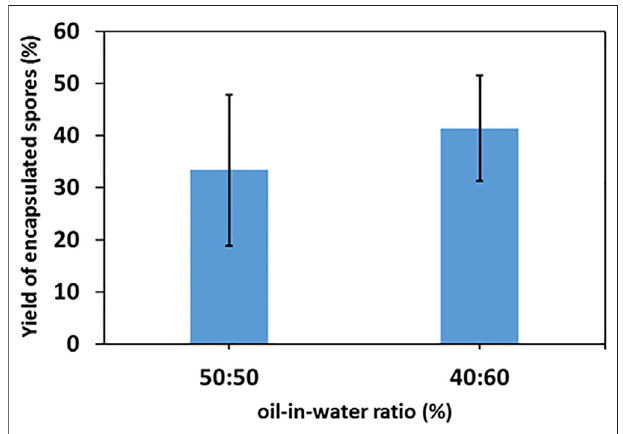
FIGURE 6 | Encapsulation yield of single-cell encapsulation of 0.02% Triton X-100 Metarhizium brunneum Mb7-GFPconidiasuspension with a1wt % titania-NH 2 content Pickering emulsion at oil/water 40:60 and 50:50 (vol%)